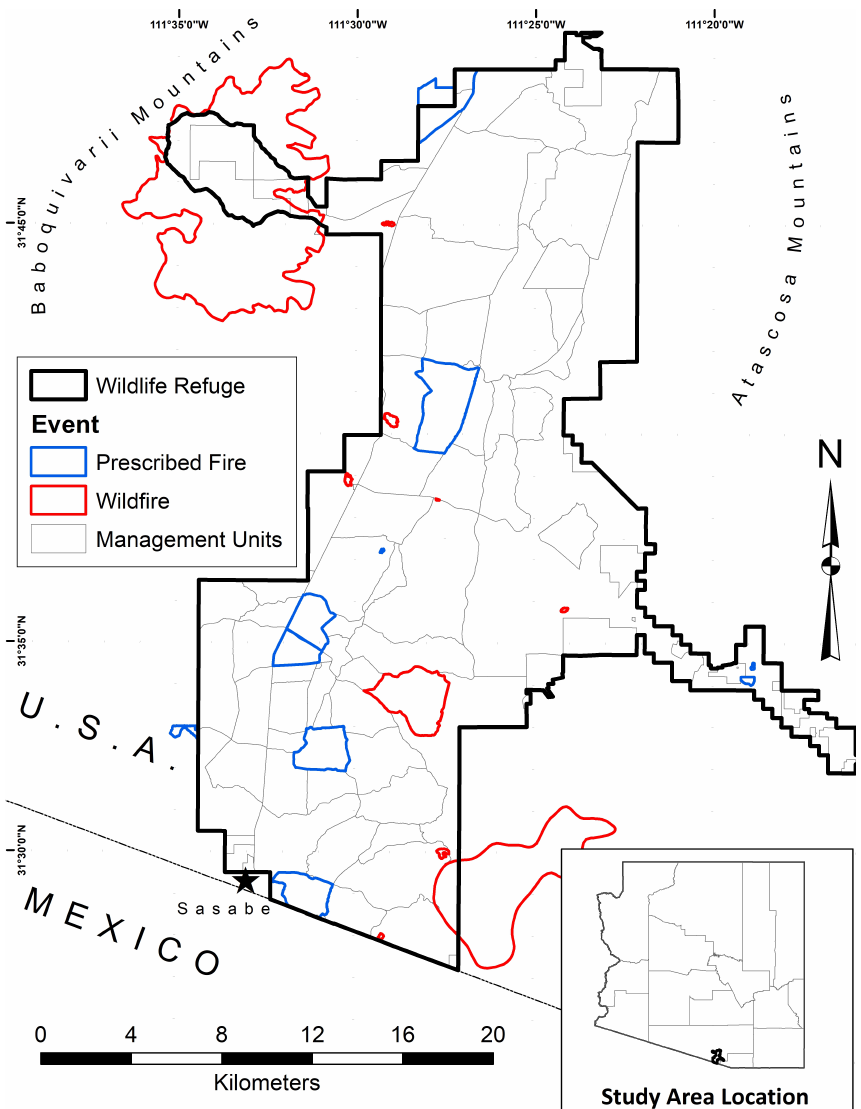
Figure 1. The Buenos Aires National Wildlife Refuge (BANWR) study area in southern Arizona, near Port of Entry Sasabe, and the location of prescribed fires and wildfires from 2015 to 2020 used for assessment of pre- and post-fire estimates of fine-fuels (NAD83(2011)/UTM-Zone 12N). Our objectives were to: (1) develop and validate a yearly model of fine-fuel, or herba- ceous vegetation biomass, over a large grassland area and (2) assess changes to, and recovery times for, fine-fuels after wildfire and prescribed fire events. A quantitative understanding of fine-fuel return intervals provides fire managers with a means for under- standing near- and long-term impacts of management actions and insight on treatment effects. In meeting our objectives, we demonstrate application of remote sensing to model- ing fuel conditions in grasslands that are prone to future non-native plant invasion and climate